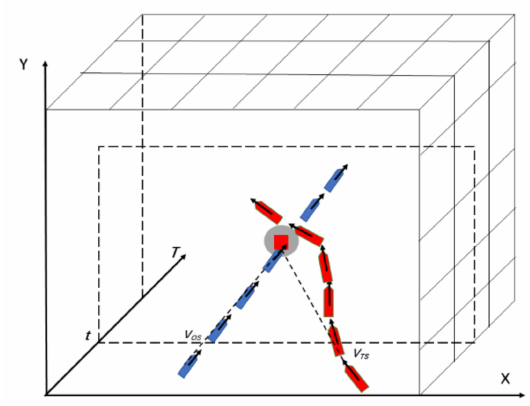
Figure 7. Multi-ship collaborative simulation